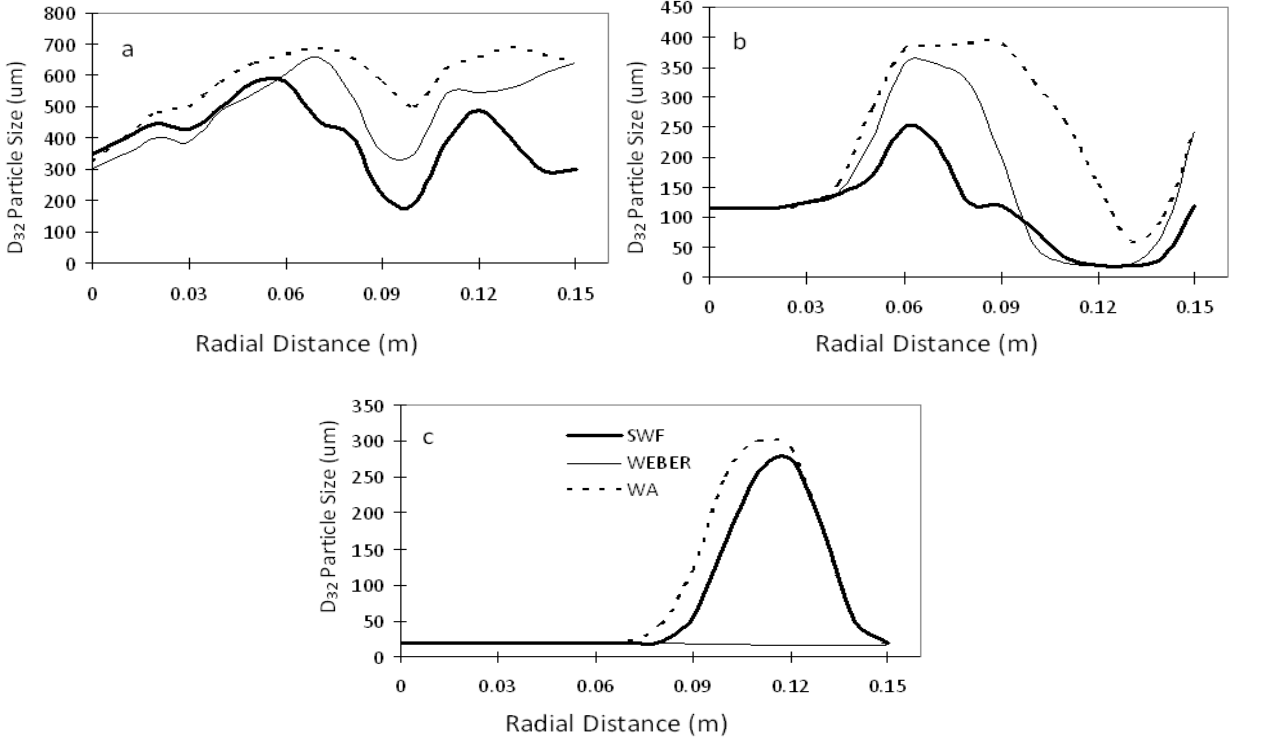
size for Al-N at ( a )100 psi (0.69 mpa); 32 2